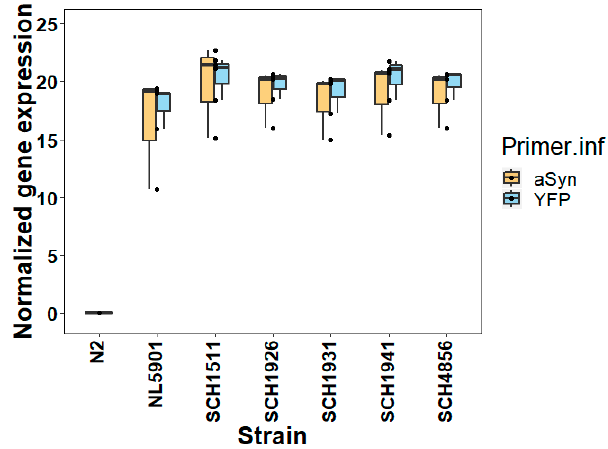
Figure 1. Gene expression levels of α -synuclein transgene in five different genetic backgrounds by qPCR. The relative expression of α -synuclein and fluorescent protein measured by RT-qPCR for these 2-day-old worms is shown; in total, there are three independent repeats in duplicate per experiment. No substantial difference was found between the expression of α -synuclein and YFP for each strain (two-tailed t-test, p > 0.05), and no difference between α -synuclein and YFP was found between the strains (two-tailed ANOVA, p > 0.05; F value = 1.72 with df = 1 for Primer.inf, and F value = 1.04 with df = 5 for strain).